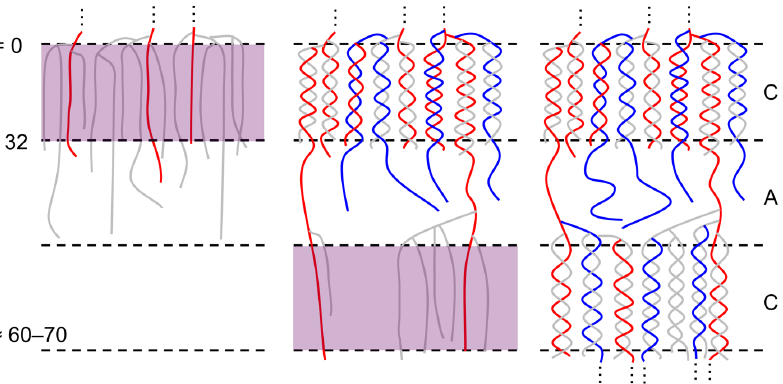
Figure 5. A proposed mechanism for the formation of the arrays of semi-crystalline lamellae in amylopectin. C and A indicate the crystalline and amorphous lamellae. The purple shaded regions indicate the nascent SL space where non-lamellar amylopectin chains, amorphous in nature, are being formed. Types of chains: (1) single-lamella (SL) chains that are (mostly) confined in crystalline lamellae (grey lines); (2) type-1 TL chains, crystalline-lamella-connecting chains, which span more than one crystalline lamellae (red lines); (3) type-2 TL chains, non-lamella-connecting chains, which protrude the SL space but remain in the amorphous lamellae (blue lines). The longest chain length confined to a crystalline lamella, predicted from Figure 2, is X , 31 (i.e. chains $ 32 enters the contiguous amorphous lamella), while longer SL chains (red lines) with X , 60–70 are sufficiently long to participate in crystalline formation in the subsequent crystalline lamella.